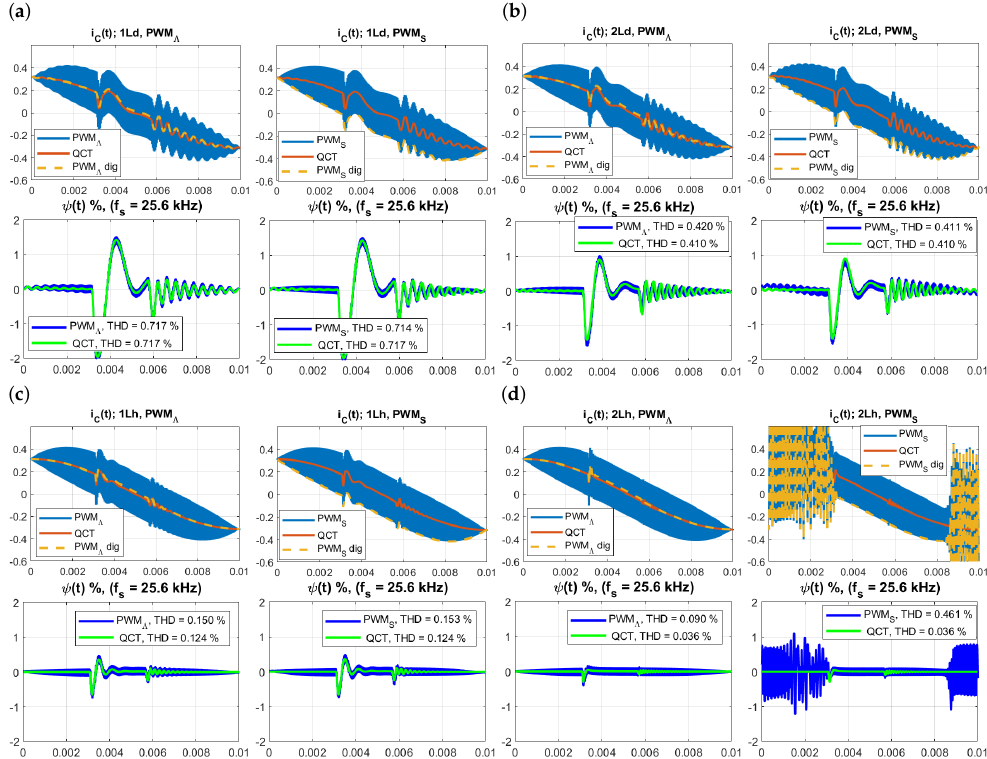
Figure 28. Influence of PWM type on control. The capacitor current i c ( t ) and distortion function ψ ( t ) are displayed for the structures ( a ) 1Ld (PID), ( b ) 2Ld (PI+P), ( c ) 1Lh (PID), and ( d ) 2Lh (PI+P) operating at 25.6